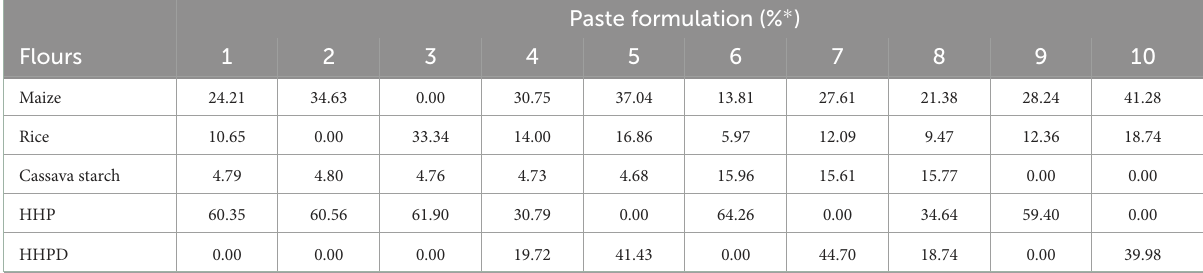
Paste formulation (% ∗ )